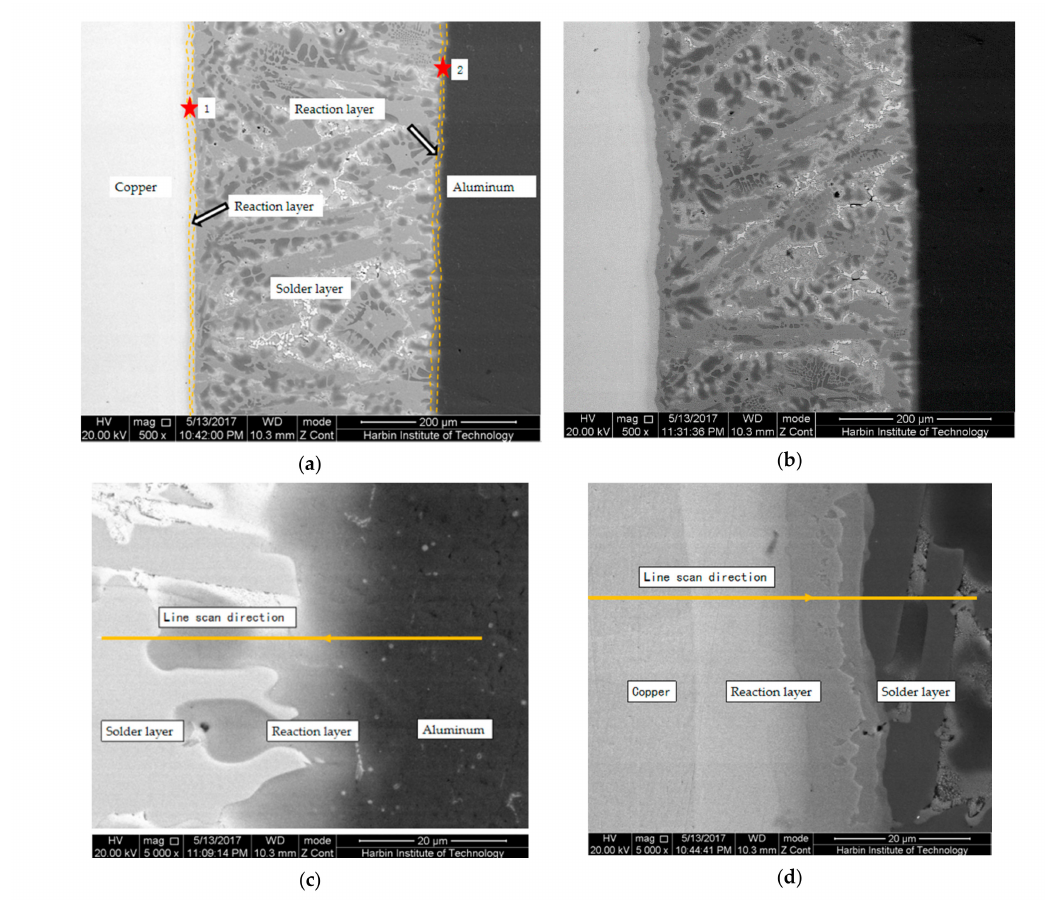
Figure 6. SEM photo of solder seam. ( a ) SEM photo of brazing seam on both sides of copper and aluminum held for 10 min. ( b ) SEM photo of brazing seam on both sides of copper and aluminum held for 1 min. ( c ) SEM photo of aluminum side brazing seam (point 2 as marked in Figure 6a). ( d ) SEM photo of copper side brazing seam (point 1 as marked in Figure 6a).